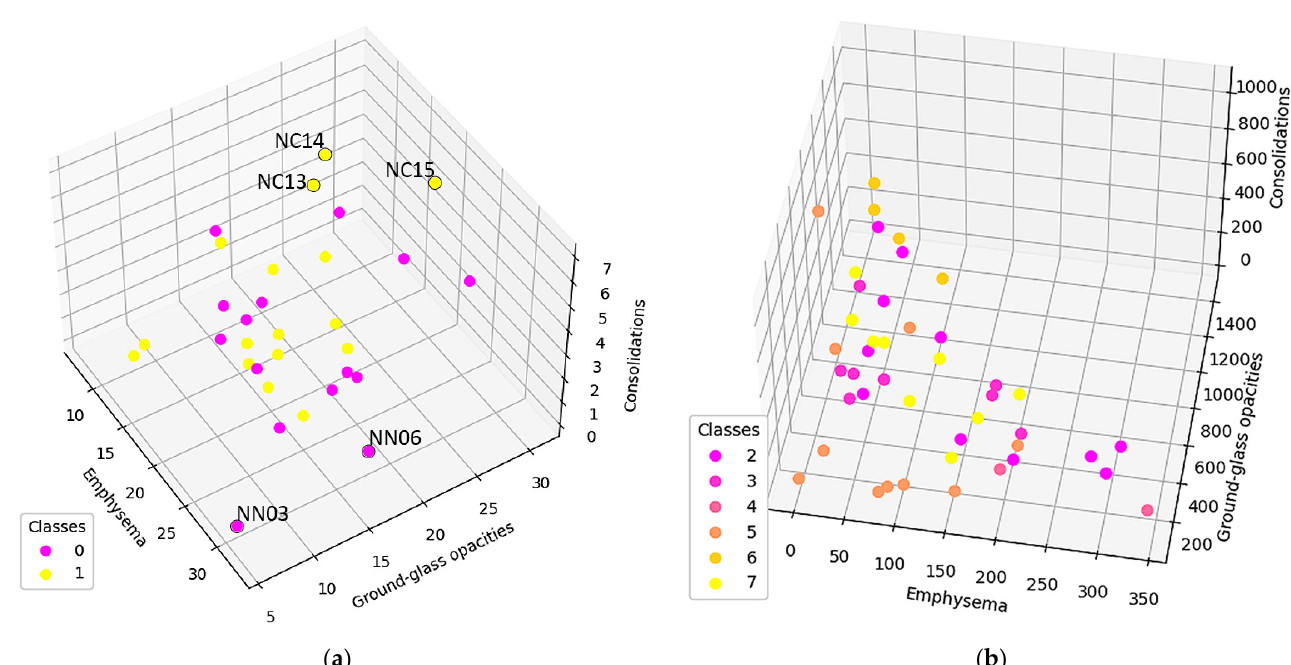
Figure 9. ( a ) Normal population plotted based on the average degree. Class 0 is the normal population investigated prior COVID ‐ 19, class 1 are cases diagnosed as normal in the pandemic era ( b ) DILD population plotted based on the average degree. Class 2 is UIP, 3 probable UIP, 4 UIP and emphysema, 5 organizing pneumonitis (OP), 6 hypersensitivity pneumonitis (HP), and 7 sarcoidosis.